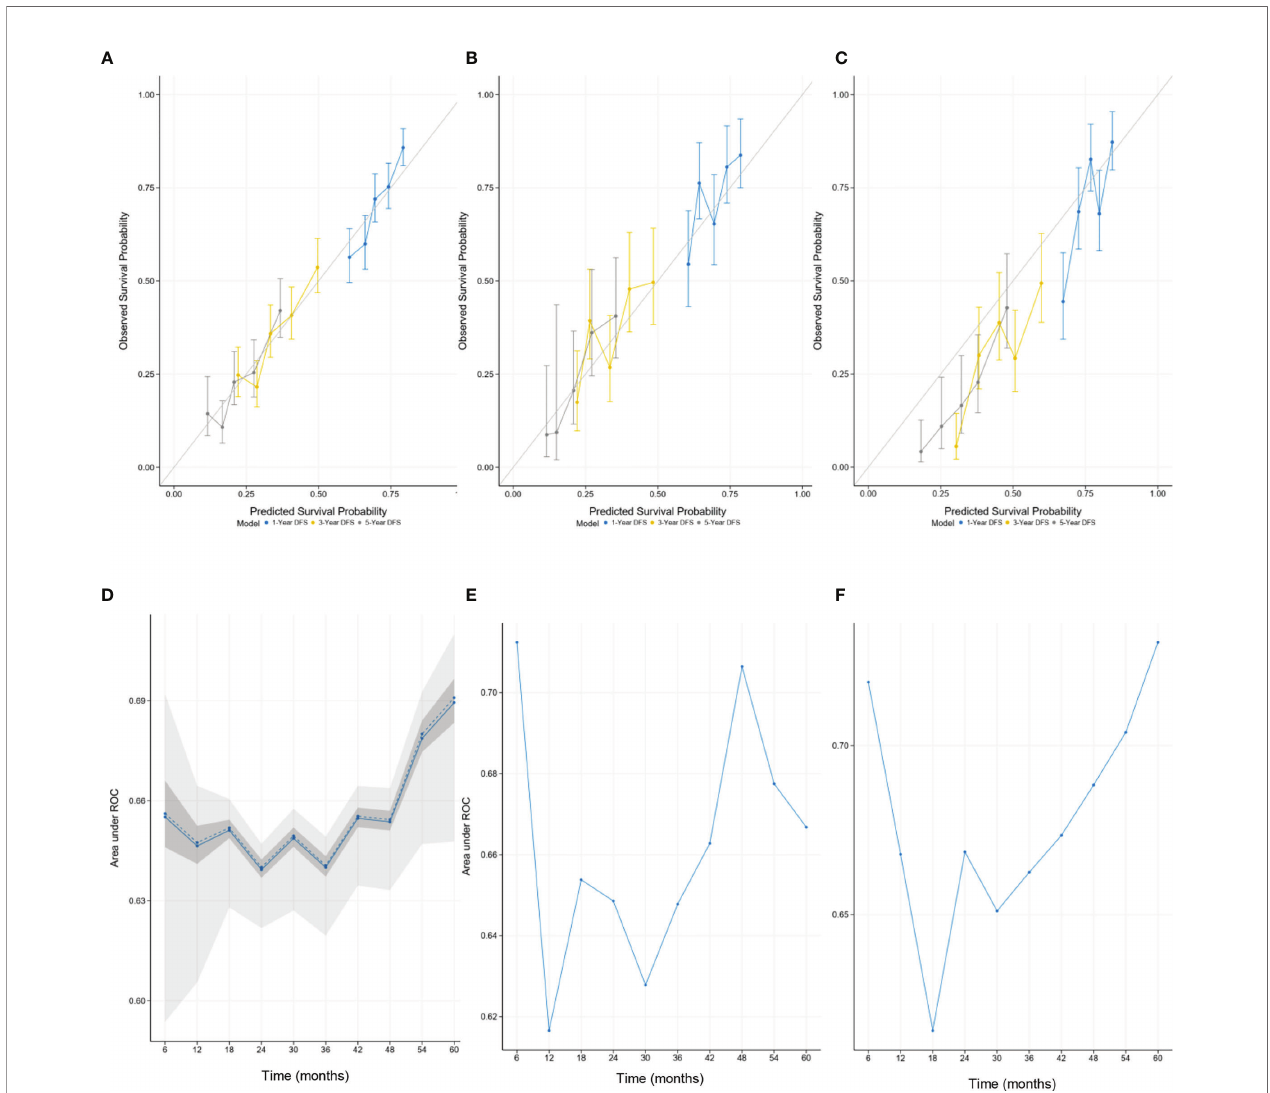
FIGURE 2 | The calibration curves for predicting patient survival at each time point in the (A) training set, (B) validation set 1, and (C) validation set 2. Nomogram- predicted disease-free survival (DFS) is plotted on the x-axis; actual DFS is plotted on the y-axis. A plot along the 45° line would indicate that the predicted probabilities are identical to the actual survival outcomes. The time-dependent AUC showed the median AUC at every 6 months in the (D) training set, (E) validation set 1, and (F) validation set 2. (D) The performance of the model in the internal validation. (E, F) The performance of the model in the external validation. AUC, area under the receiver operating characteristic